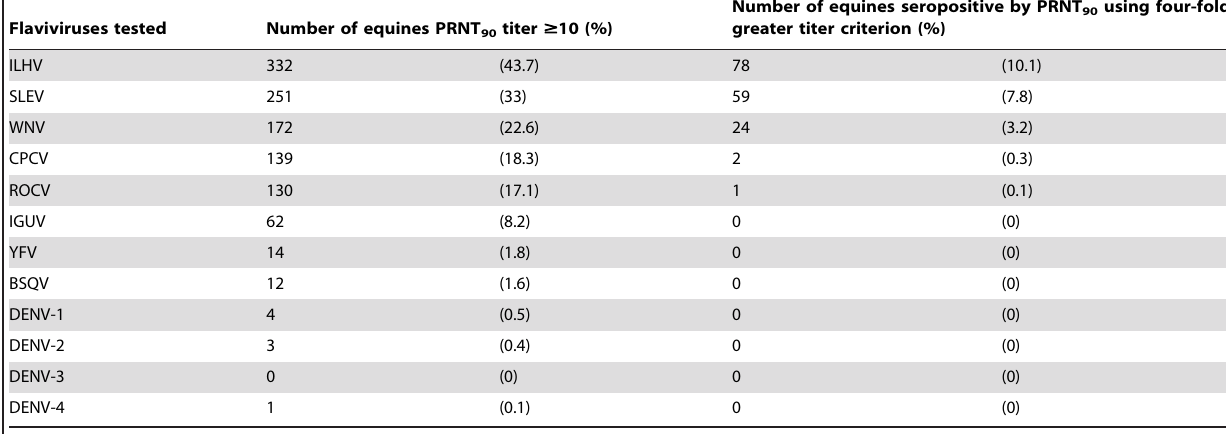
Flaviviruses tested